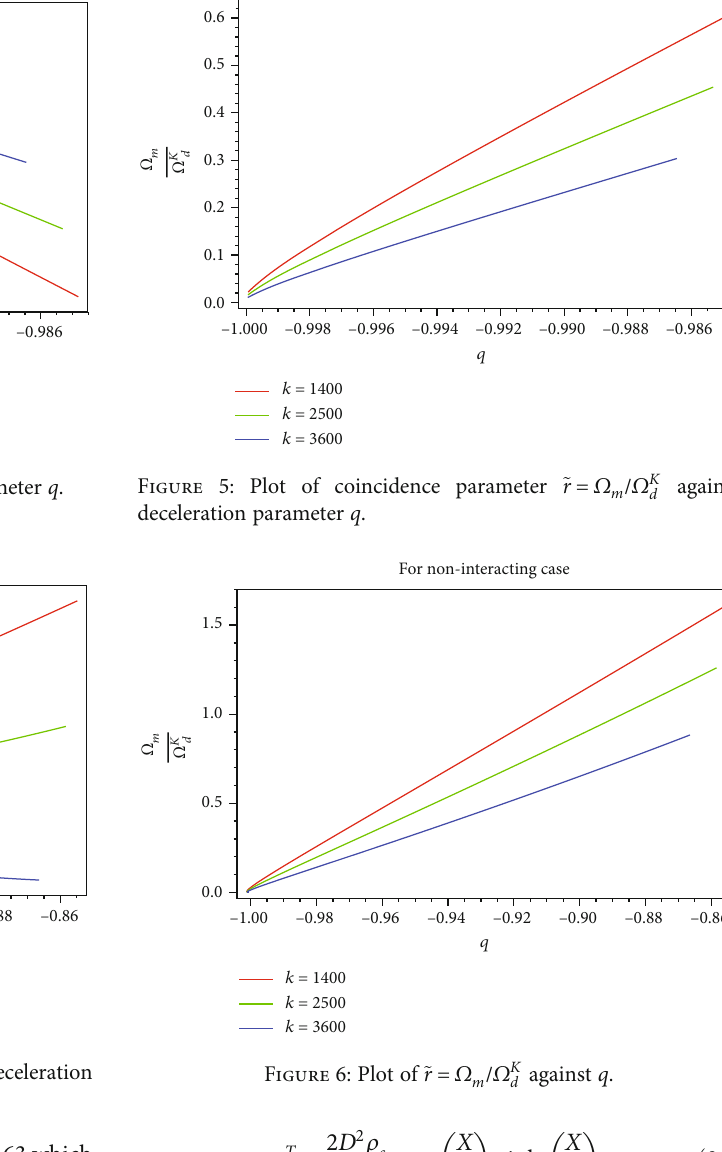
/ Ω K against q . m d